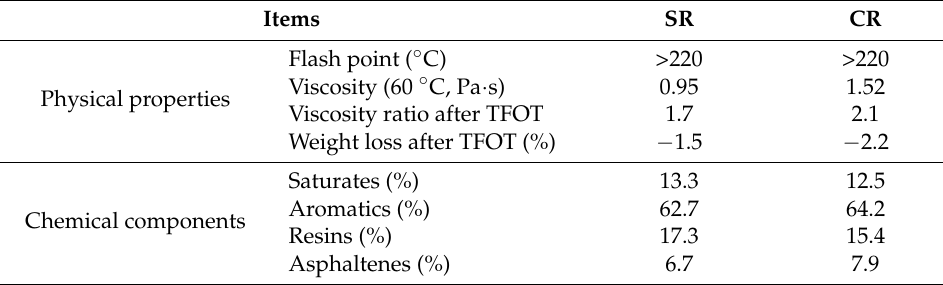
Table 2. Physical properties and chemical components of SR and